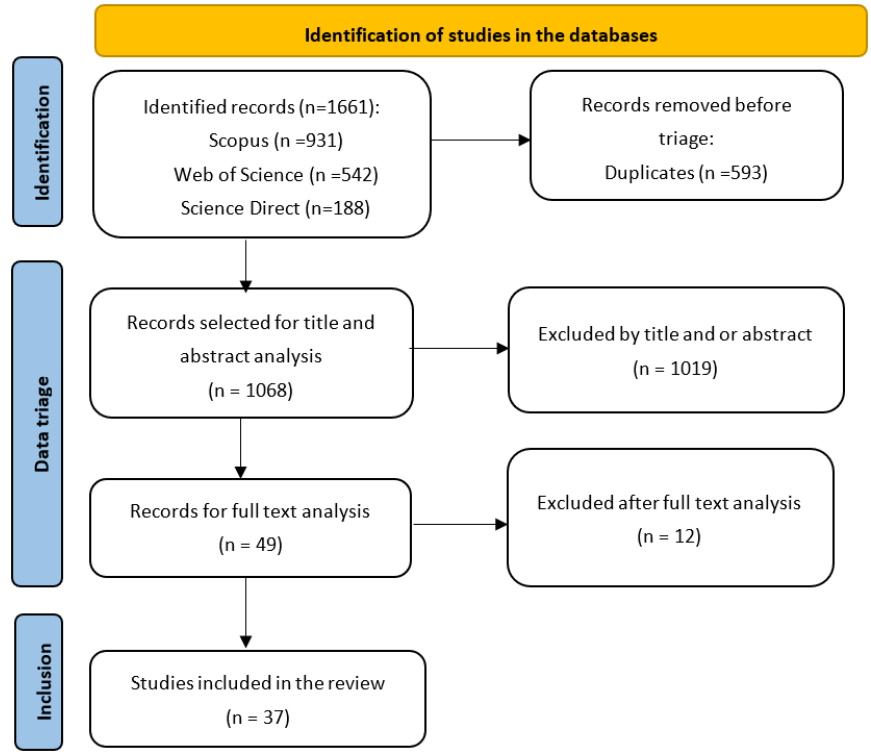
Figure 1. Selection flowchart of studies to be reviewed.